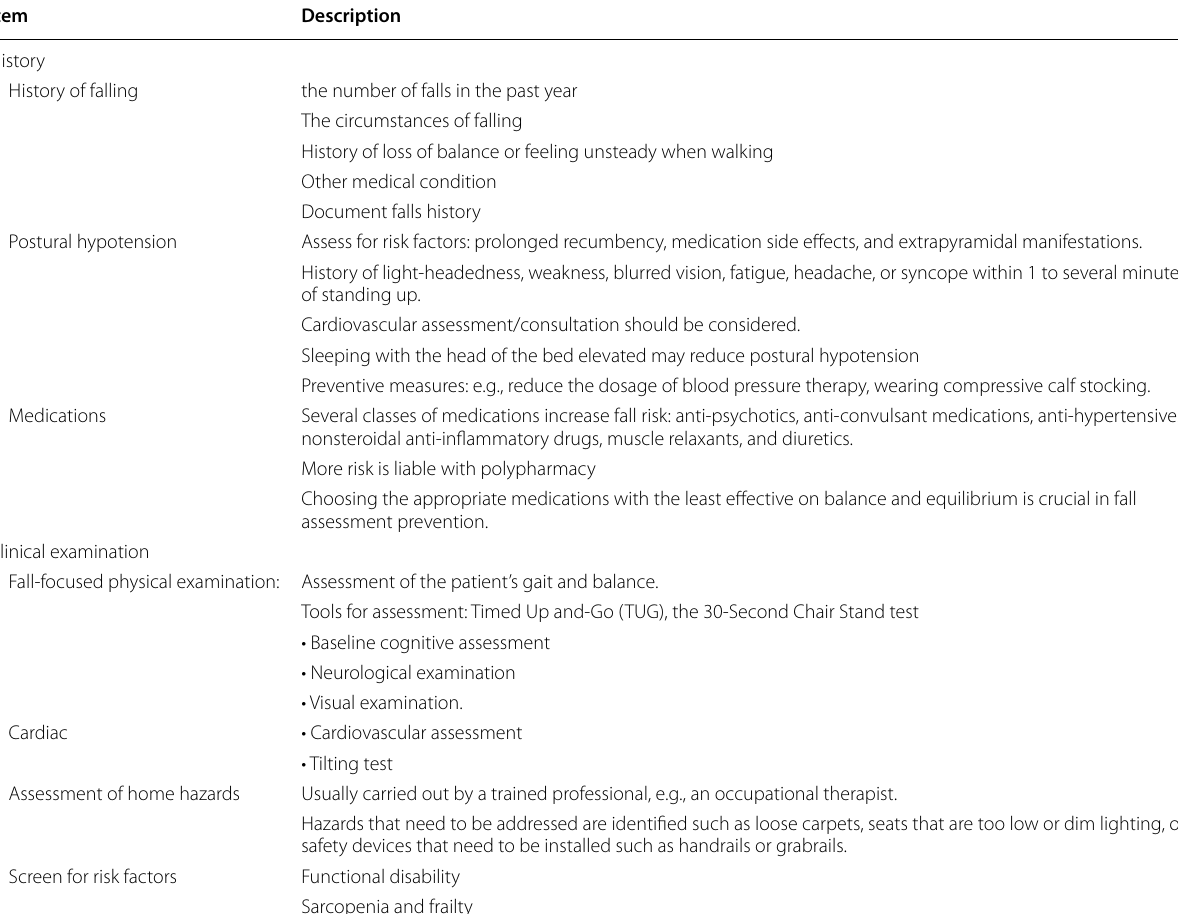
Table 1 Clinical assessment of patients at risk of falling or who present with history of